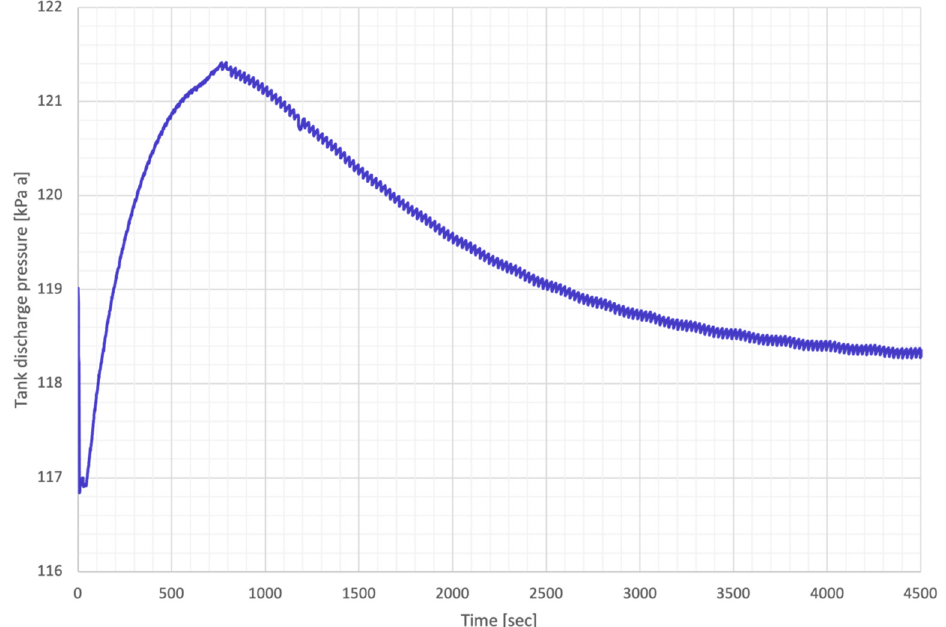
Figure 12. Tank discharge pressure.